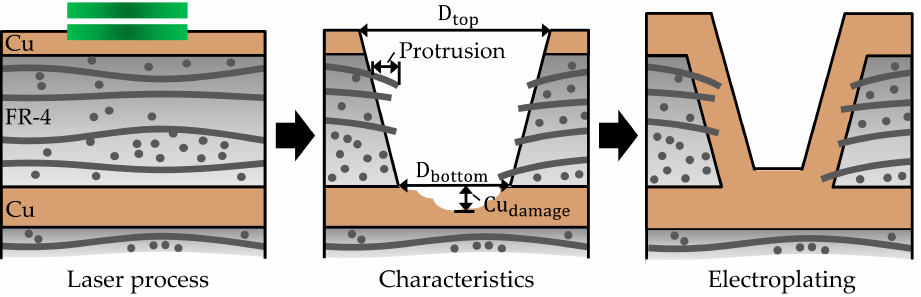
Figure 1. Laser-based fabrication of microvias in FR-4 PCB material and their technical specification based on the taper (ratio of the upper to lower diameter), glass fiber protrusion, and damage in the inner copper layer Cu damage